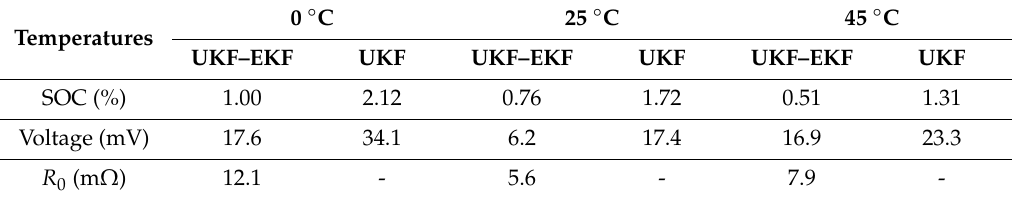
Table 2. The estimation of root mean square errors (RMSEs) for the UKF–EKF and UKF under US06. Temperatures